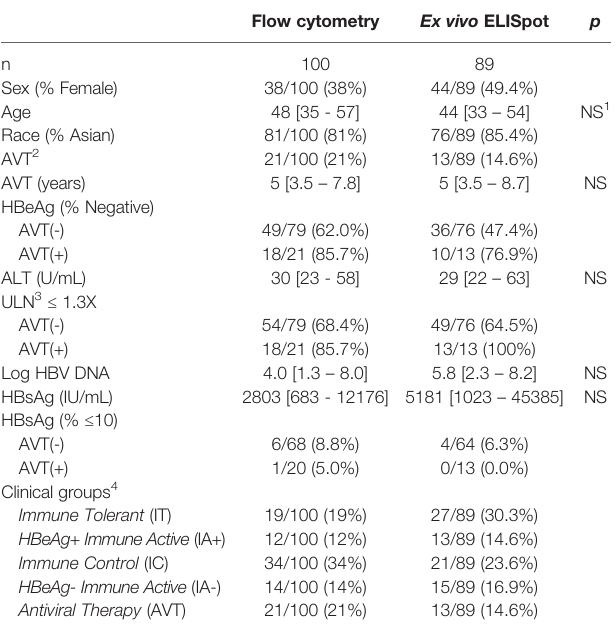
TABLE 1 | Characteristics of the cohort.